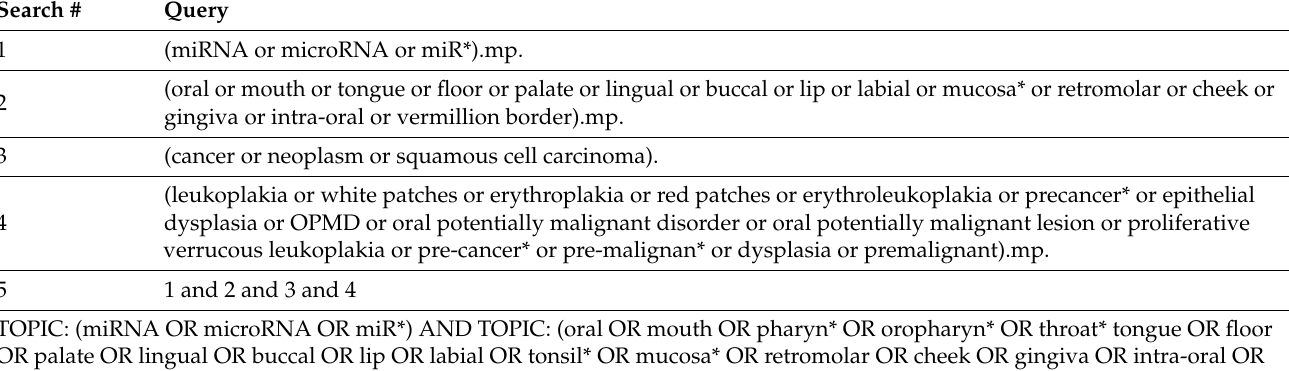
Table 1. Search strategies applied to the databases: Medline (Ovid), Embase (Ovid), EBM Reviews (Ovid), Search strategy applied to the database: Web of